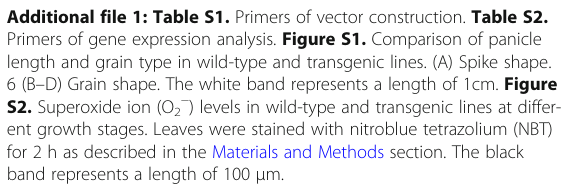
Additional file 1: Table S1. Primers of vector construction. Table S2. Primers of gene expression analysis. Figure S1. Comparison of panicle length and grain type in wild-type and transgenic lines. (A) Spike shape. 6 (B – D) Grain shape. The white band represents a length of 1cm. Figure S2. Superoxide ion (O 2 − ) levels in wild-type and transgenic lines at differ- ent growth stages. Leaves were stained with nitroblue tetrazolium (NBT) for 2 h as described in the Materials and Methods section. The black band represents a length of 100 μ